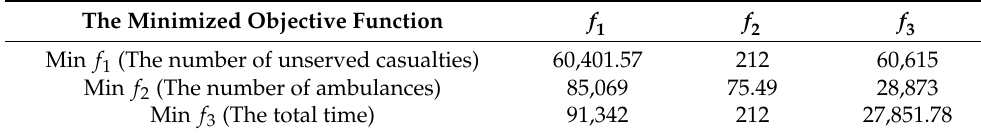
Table 2. Payoff table